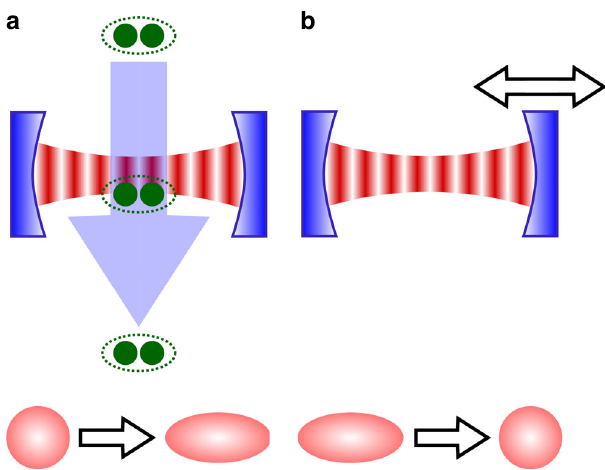
Fig. 7 Squeezing and unsqueezing of a cavity mode. a The interaction of a cavity mode with a squeezed thermal bath (stroke 2 in Fig. 5) may be realised in a micromaser setup where a beam of entangled atom pairs passes through the cavity 36 . b The unsqueezing operation in stroke 3 of Fig. 5 may be implemented by a suitable modulation of the cavity frequency 68 – 70